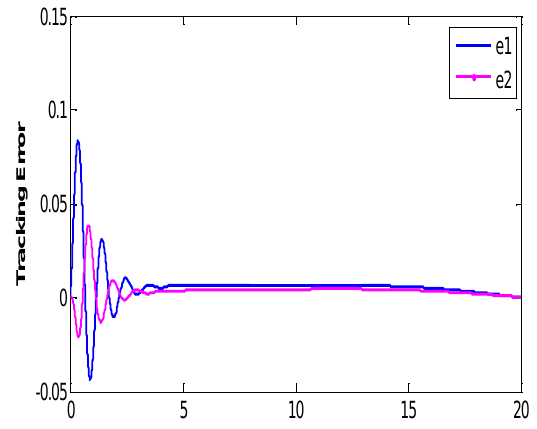
Figure 9. Tracking performance of proposed approach in optimal